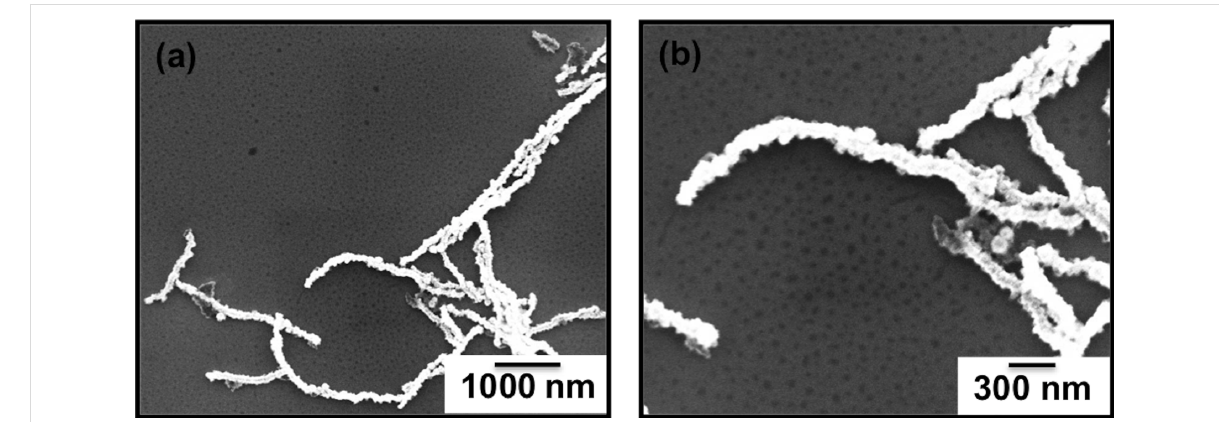
Figure 1: SEM images of the Au@Co nanochains at (a) low magnification and (b) high magnification.